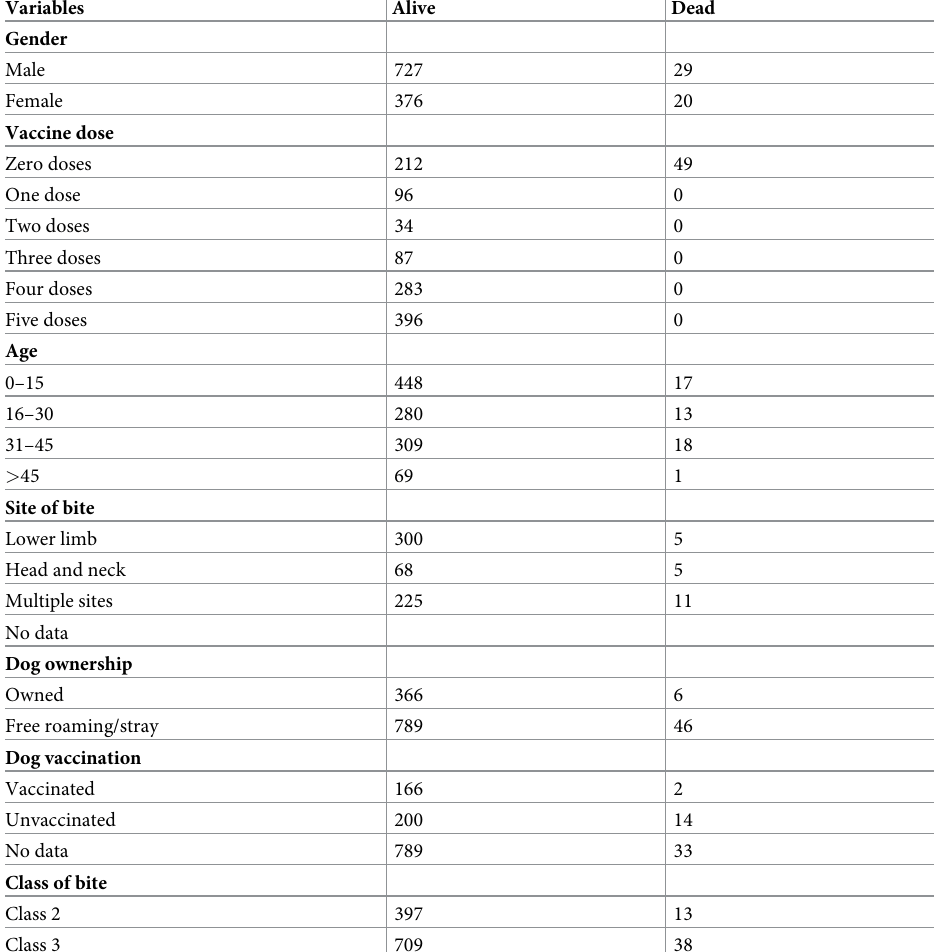
Table 1. Distribution of variables among victims of dog bite who died or were alive following a dog bite in Abuja between 2000 and 2018.